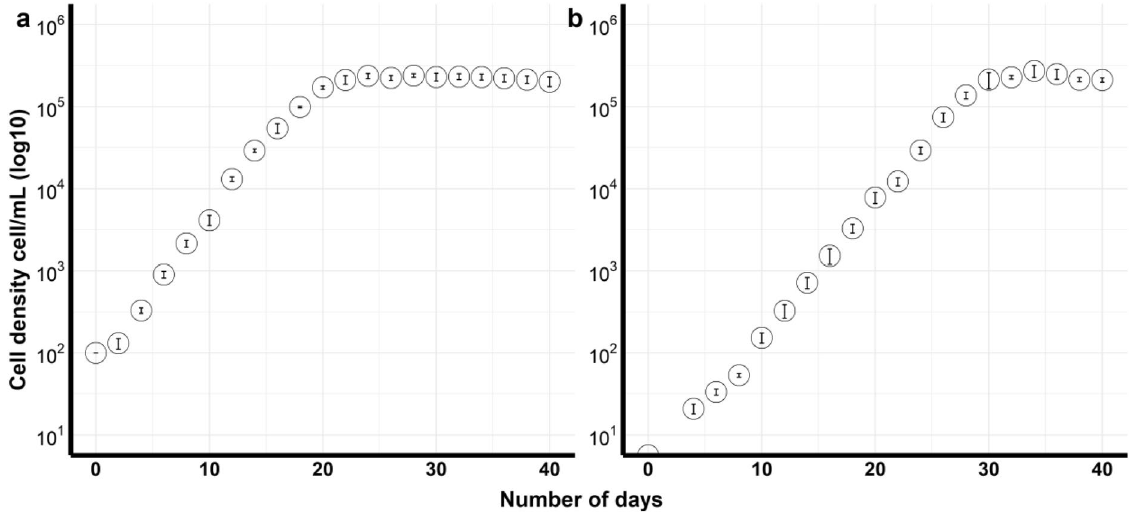
Figure 5. Growth curves of Breviolum sp. cultures with standard error bars. ( a ) Control (non-cryopreserved) culture, ( b ) Cryopreserved